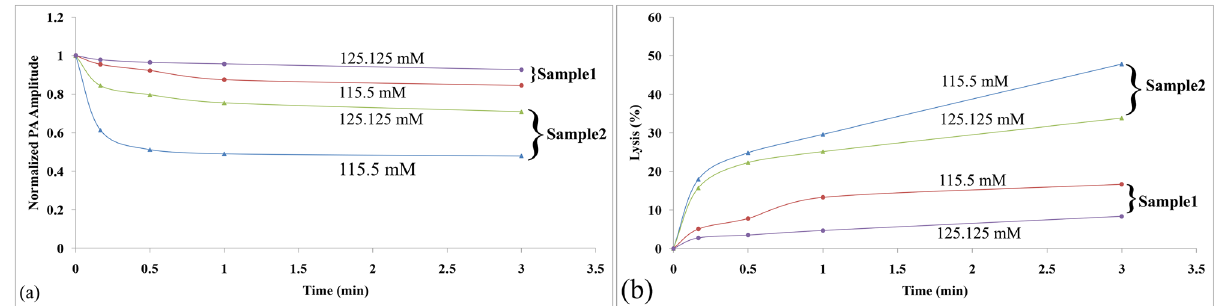
Figure 5. Result of similar measurement done on a different porcine blood sample (sample 2) in 115.5 mM and 125.125 mM osmolarity, showcasing different rate of change of ( a ) PA amplitude as well as ( b ) lysis percentage with time (min) indicating higher cell fragility compared to the primarily reported sample (sample